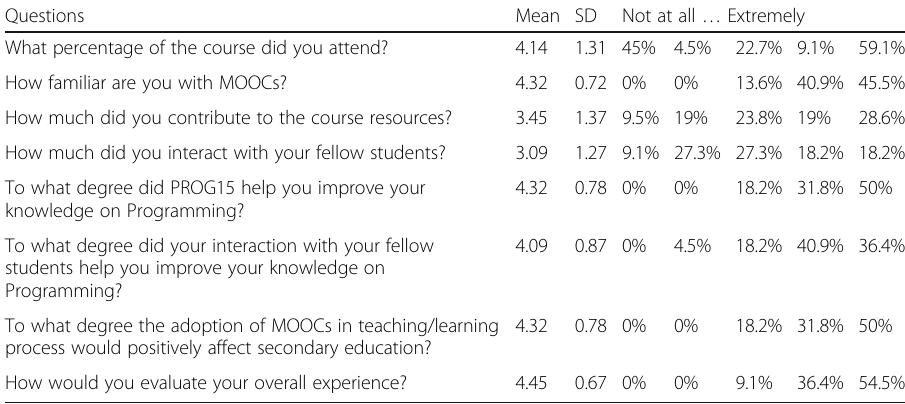
Table 4 Students ’ responses after-PROG15 ( Ν = 22)